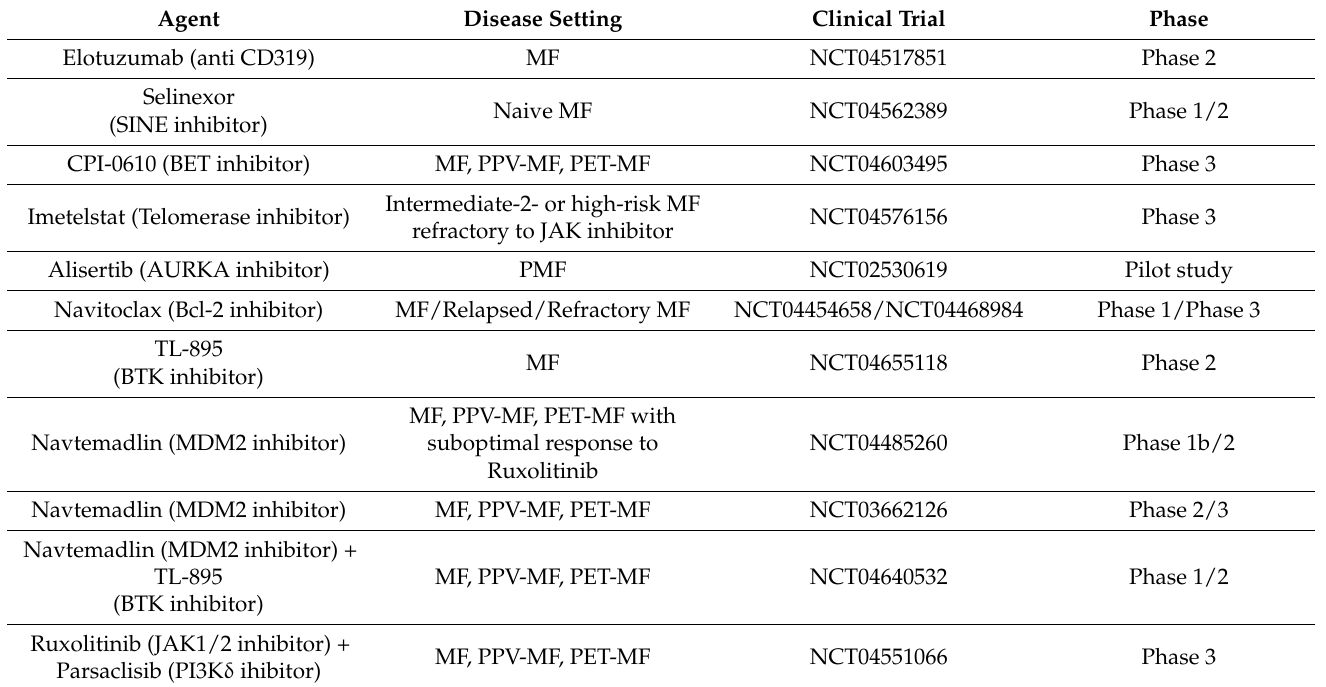
Table 2. Some of ongoing clinical trials with novel agents other than JAK2 inhibitors.